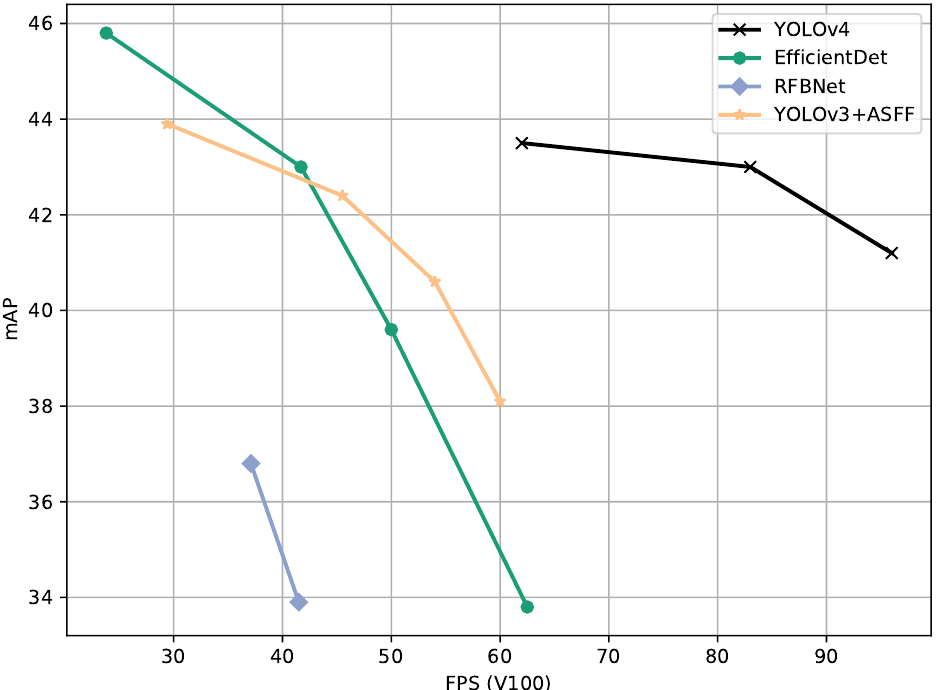
Figure 1. Example of a typical graphical model comparison on the COCO test set (data from Bochkovskiy et al. (2020)